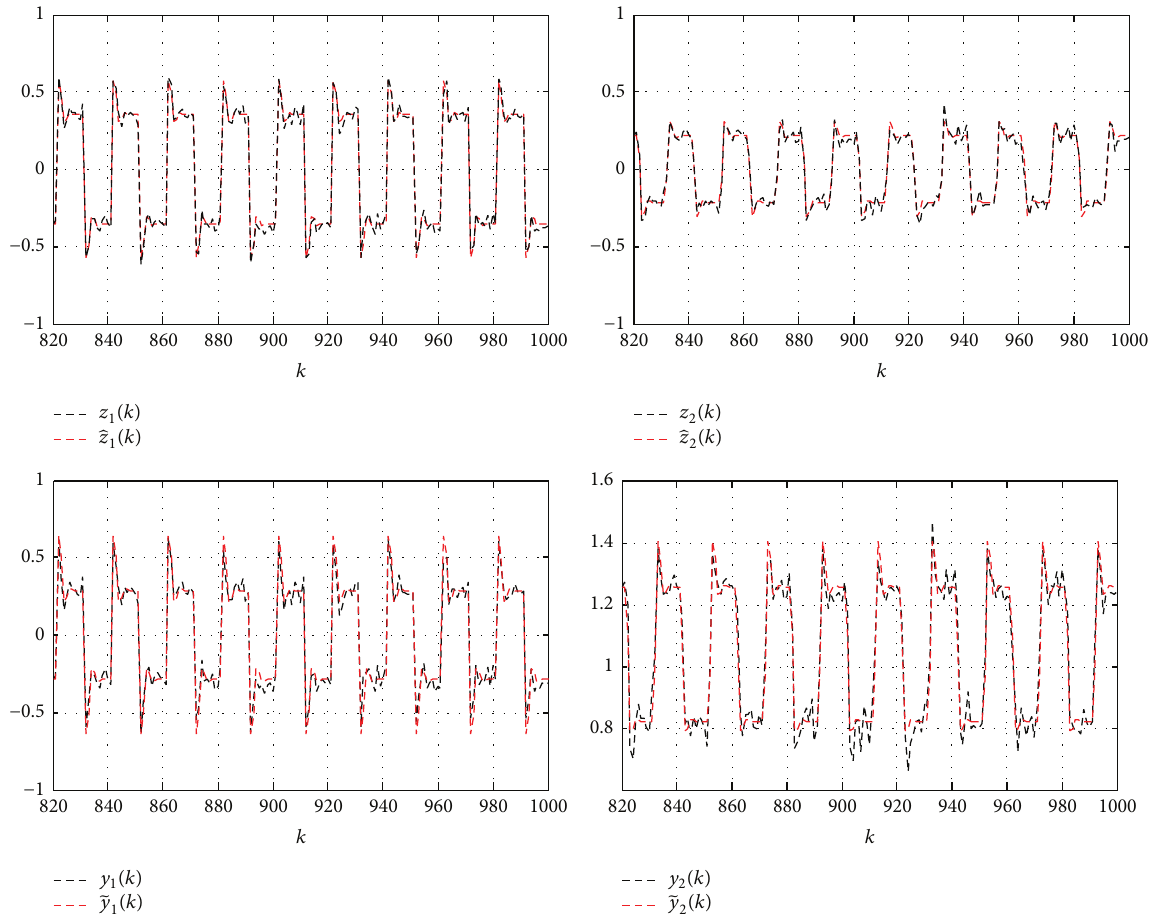
Figure 3: The internal variables 𝑧 1 (𝑘) and 𝑧 2 (𝑘) and their estimates ̂𝑧 1 (𝑘) and ̂𝑧 2 (𝑘) and the outputs 𝑦 1 (𝑘) and 𝑦 2 (𝑘) with the predicted outputs ̃𝑦 (𝑘) and ̃𝑦 (𝑘) 1 2